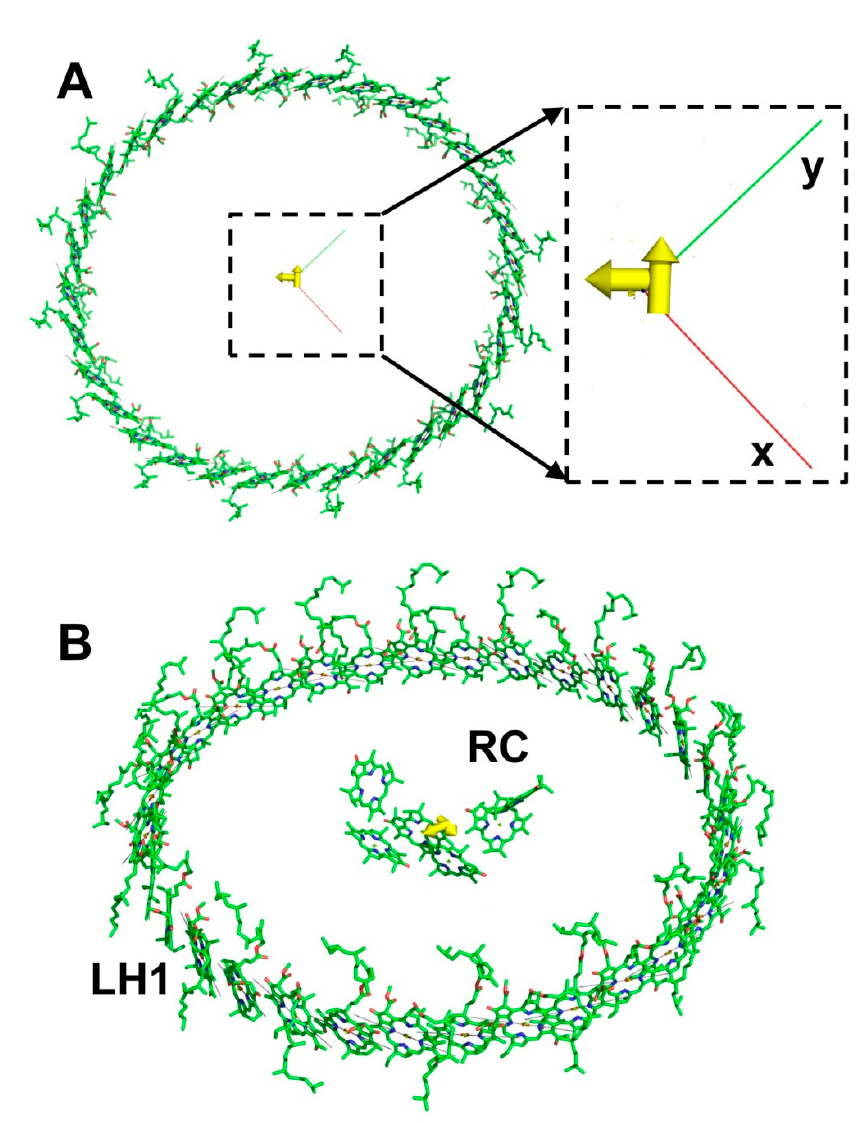
Figure 6. Exciton transition moments D µ (yellow arrows) calculated for the core antenna of the LH1-RC complex in the case of the isoenergetic material Hamiltonian ( A ). The transition moments for the two most intensive exciton states are shown together with the pigments of RC ( B ).